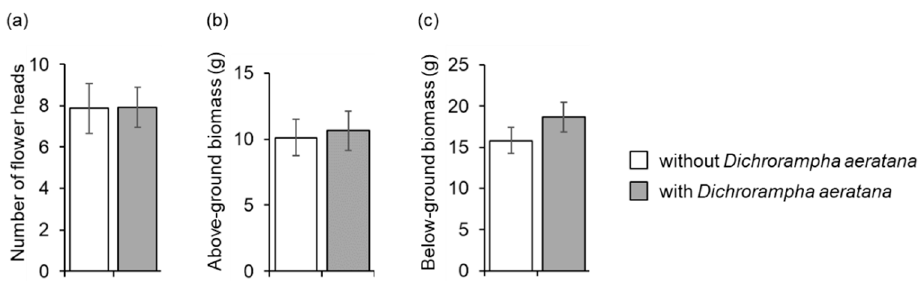
Figure 3. Mean ( ± SE) ( a ) number of flower heads, ( b ) above-ground biomass, and ( c ) Figure 3. Mean (± SE) ( a ) number of flower heads, ( b ) above-ground biomass, and ( c ) below- ground biomass of the Shasta daisy cultivar Leucanthemum × superbum ‘Amelia’ infested with 30 larvae of Dichrorampha aeratana and non-infested plants. The plants were infested with larvae in April 2013 and measurements were taken in July 2014.